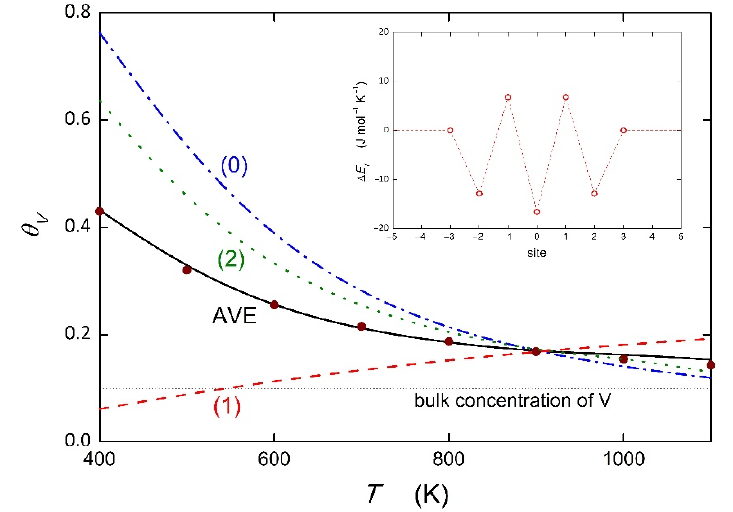
Figure 4. Temperature dependence of V segregation at individual sites 0, ± 1 and ± 2 at the {111} grain boundary of bcc iron calculated according to Equation (2) for the values of ∆ H V published in [18] (see the inserted Figure) and the respective values of ∆ S V determined by Equation (7) from [25]. Individual dependences are depicted by the dashed, dotted and dash-dotted lines. The full line corresponds to the arithmetic average of the grain boundary concentrations over all sites (AVE), the solid symbols represent the data obtained by means of the predicted values ∆𝐻 (cid:3023)(cid:2868) = − 7.9 kJ mol − 1 , ∆𝑆 (cid:3023)(cid:2868) = − 3.8 J mol − 1 K − 1 , and 𝛼 (cid:3023) = +0.9 kJ mol − 1 ; data from [25].